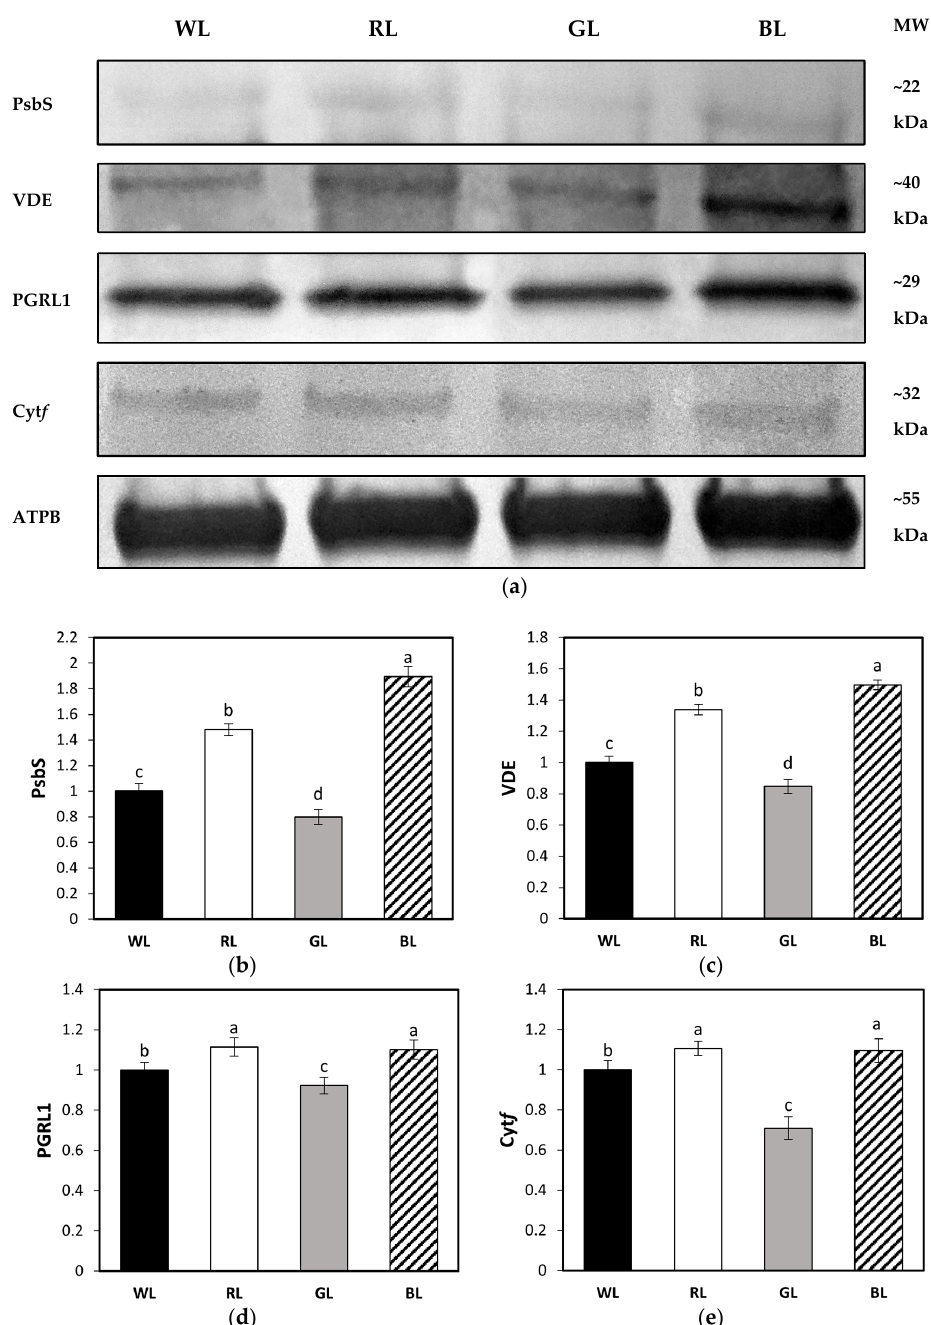
Figure 9. Western Blot analyses ( a ) and densitometric analyses of PsbS ( b ), VDE ( c ), PGRL1 ( d ), and cyt f ( e ) proteins in leaves of tomato plants ( Solanum lycopersicum L. cv. Malinowy Ozarowski) grown under different light conditions (see Material and Methods for details). The bands were normalized to the appropriate β subunit of ATP synthase (ATPB) band (loading control, Figure S4) ( a ). The bar diagrams ( b – e ) represent pixel volumes (densitometric analyses) of proteins in samples. Each value represents the mean ± SD ( n = 3) considering the control sample (WL) value as 1 (100%). Different letters indicate significant differences between treatments ( p = 0.05) with a Tukey’s HSD test. MW—molecular weight.